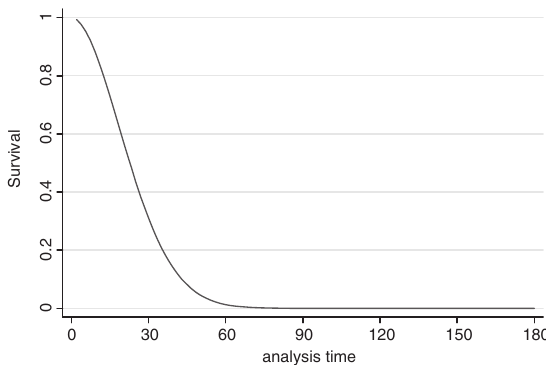
Fig. 4. The predicted survival curve of the home-to-work